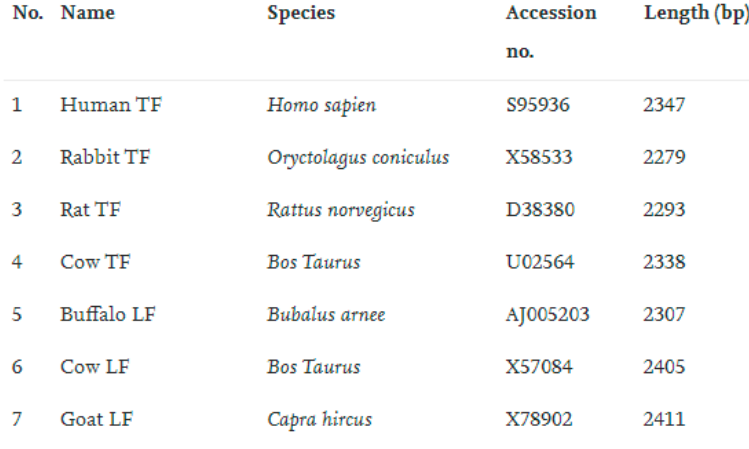
Figure 3. An example of the attribute-value pair [30].